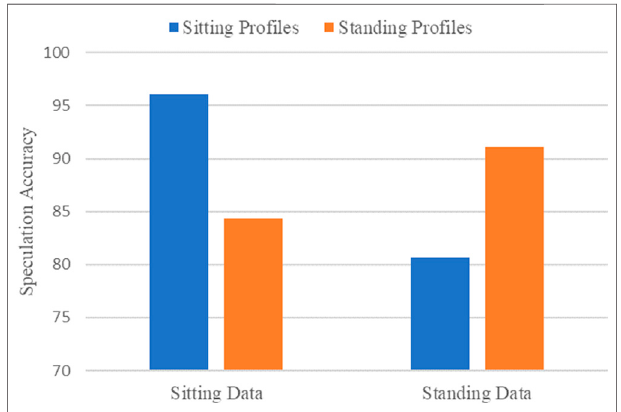
FIGURE 8 | Performance of different holding